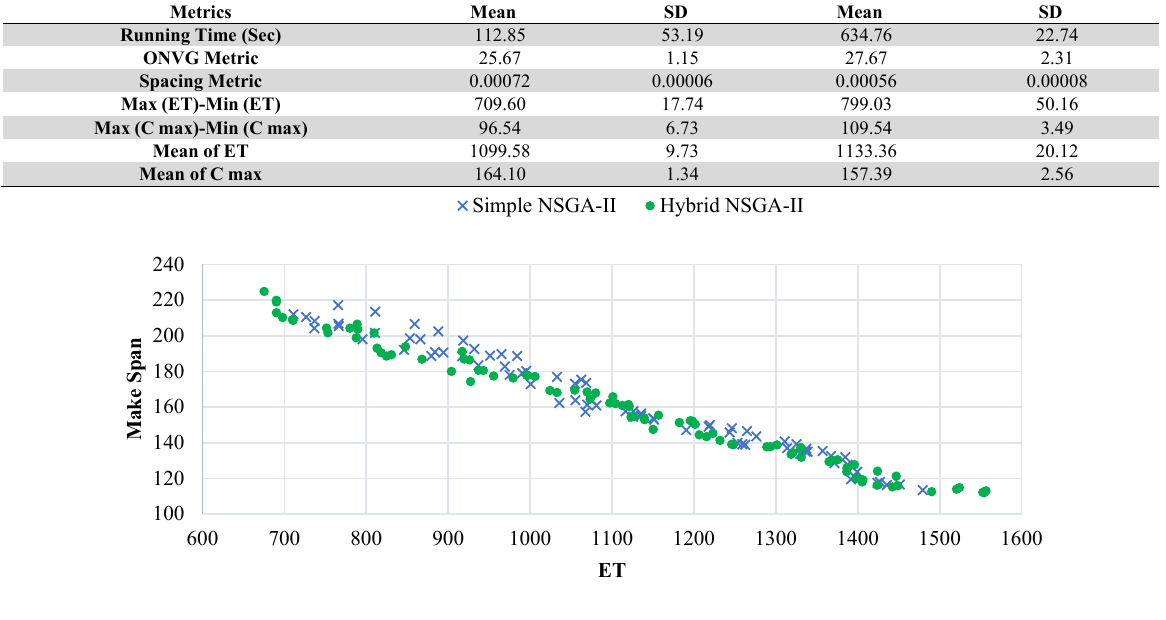
Fig. 3. Partition fronts for two simple and combined algorithms for 16 jobs and 4 machines.